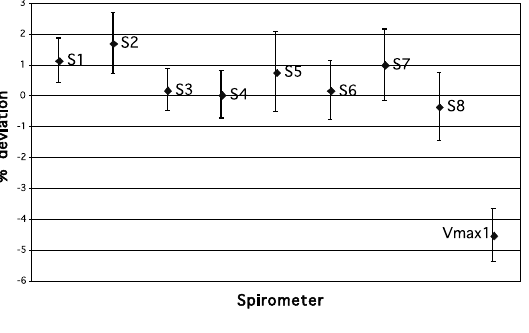
Device-specific mean (and 95% CI) devia- tion in percent from personal mean FVC calculated across re- sults taken at all de- vices in test series 2.